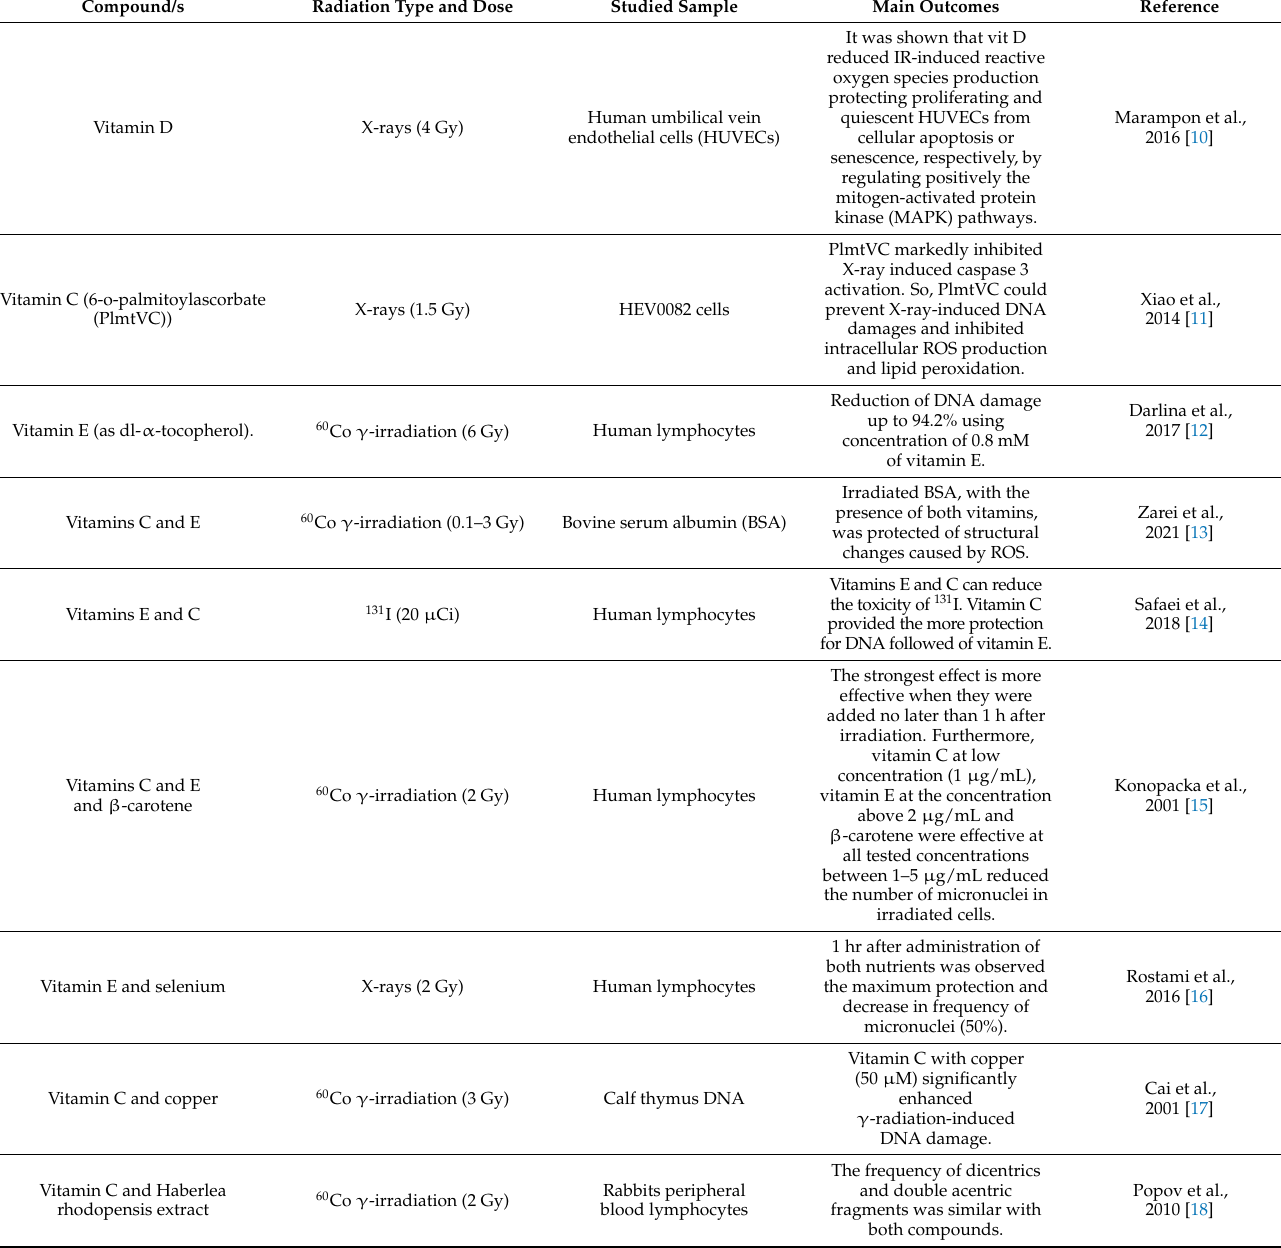
Table 2. In vitro studies about radioprotective effect of vitamins.